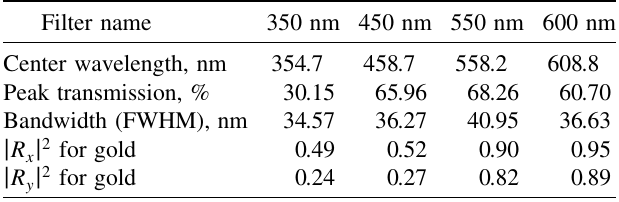
TABLE IV. Parameters of optical filter.